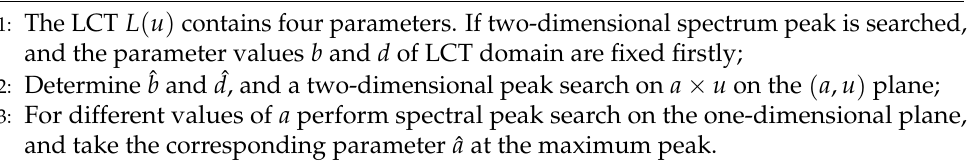
Algorithm 2 Extraction of spectrum peak in LCT domain.